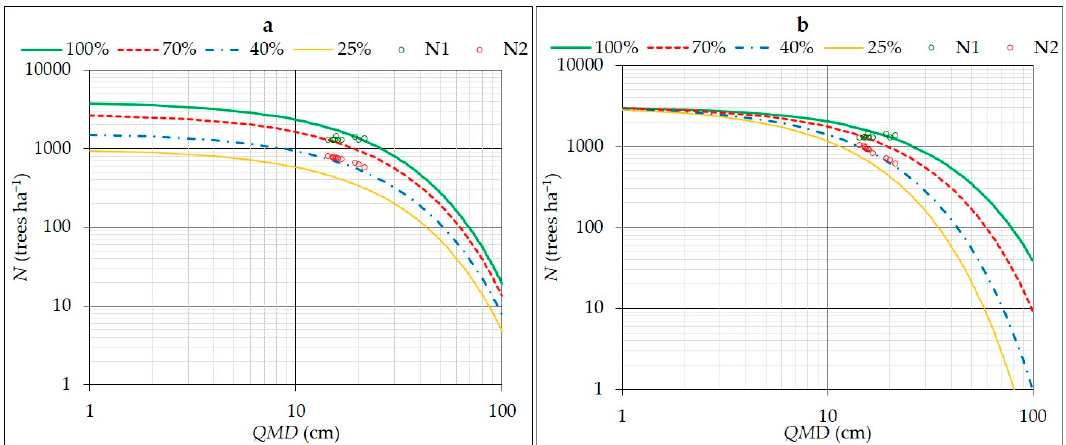
Figure 7. Graphical thinning schedule for ten mixed-species stands with DMGs based in exponential equation: SDI dependent on intercept parameter (EE-SDI ( β 0) ; ( a )) and on slope parameter (EE-SDI ( β 1) ; ( b )). N1 represents the trees per hectare at a specific QMD (e.g., Table 6) before thinning schedule and N2 represents the trees per hectare at a specific QMD after thinning schedule with the same QMD for N1 and N2. Table 6. Thinning schedule for mixed-species stands with DMGs for the exponential equation. Stand QMD